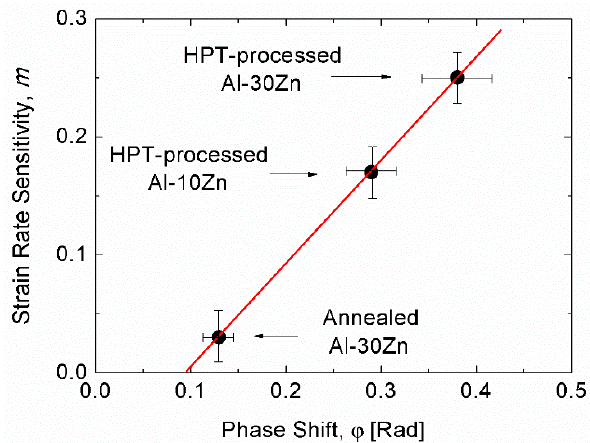
Figure 12. Correlation between the phase shift, ϕ and the SRS of Al-Zn alloys. Reproduced with permission from [75]. Copyright 2019, Materials Research Society.